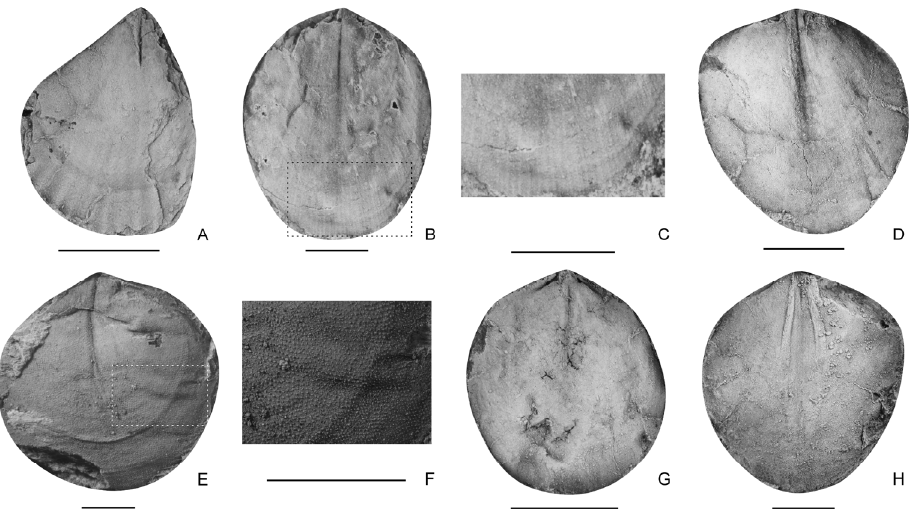
Figure 7. Paradoxothyris flatus sp. nov., ( A , B ), internal moulds of ventral valves, LD380016, LD380303, ( C ), enlarged area of ( B ); ( D – H ), internal moulds of dorsal valves, LD380100, LD380419, LD380125, LD380204, ( F ), enlarged area of ( E ). Scale bar = 2 mm. Derivation of name. In reference to the low convexity of both valves.